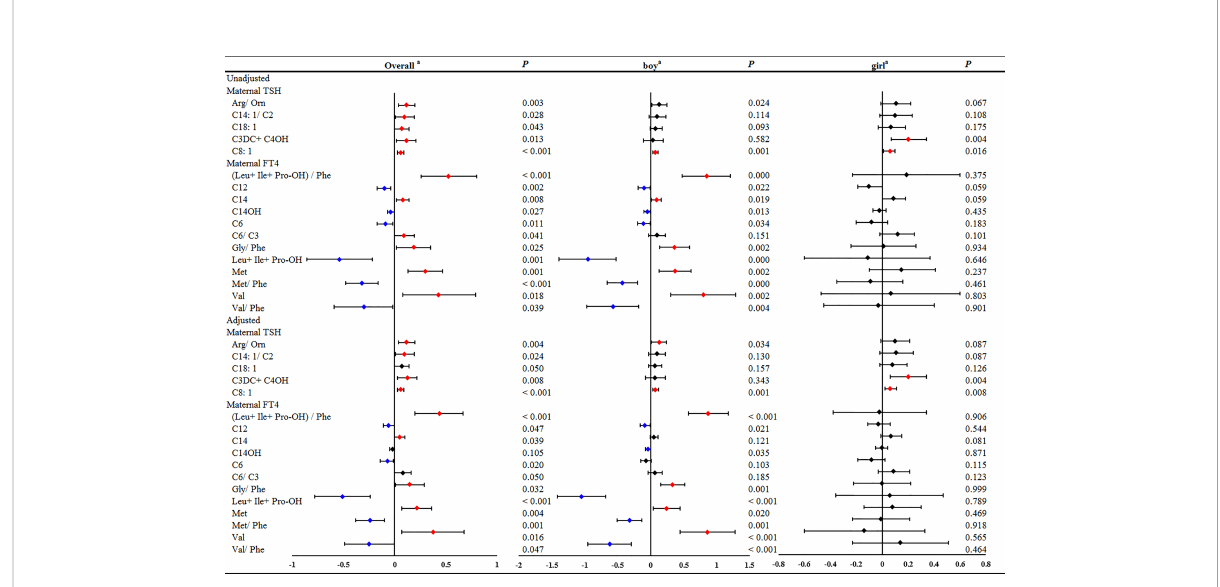
FIGURE 2 The signi fi cant linear associations of maternal serum THs with part of neonatal metabolites during overall pregnancy or in different genders of newborn. GLM Model a: adjusted by the age of pregnant women, gestational weeks at sample collection, newborn birth weight and gestational age at